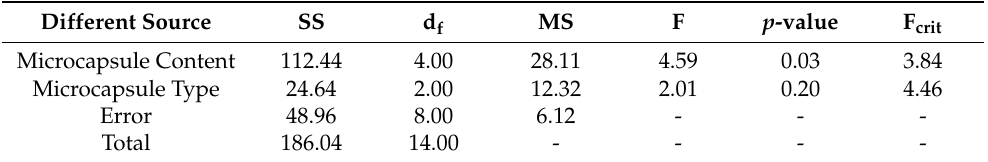
Table 3. Significance analysis of ∆ E* of coatings with the different content of different shellac microcapsules based on the Beli wood surface.